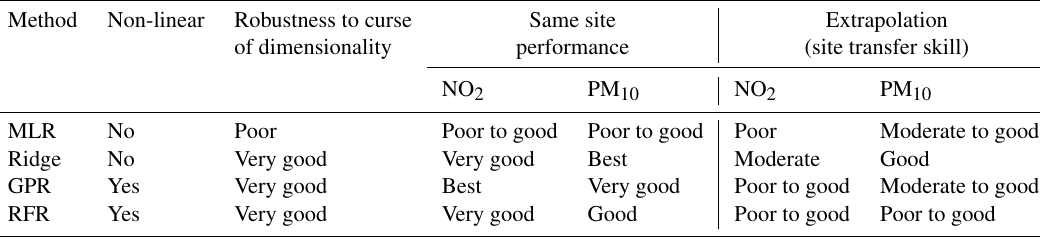
Table 4. Summary and qualitative evaluation of key features of each of the four regression algorithms. The robustness to the curse of dimensionality refers to how well each algorithm can handle an increase in the number of calibration variables. In addition, we summarize how well each method performs for our calibrations here if evaluated against test data sampled at the same site as the one used for training and after site transfers. The variable performance of GPR (and also RFR) for site transfers is mainly the result of its limited skill to extrapolate so that its performance will always depend strongly on how representative the training data is in terms of value ranges. We also note that robustness to the curse of dimensionality (third column) is only considered with respect to the maximum of 72 predictors considered here. In even higher dimensions more significant differences across the machine learning methods are expected to occur eventually. Method Non-linear Robustness to curse Same site Extrapolation of dimensionality performance (site transfer skill) NO 2 PM 10 NO 2 MLR Yes Very good Best Poor to good Moderate to good RFR Yes Very good Very good Good Poor to good Poor to